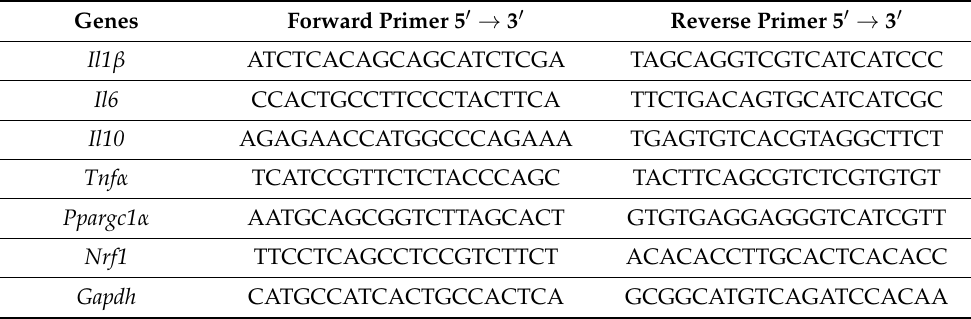
Table 2. Primers used for real-time PCR analyses. IL, interleukin; Tnf α , tumor necrosis factors- α ; Ppparg 1 α , peroxisome proliferator-activated receptor coactivator-1 α ; Nrf1 , nuclear respiratory